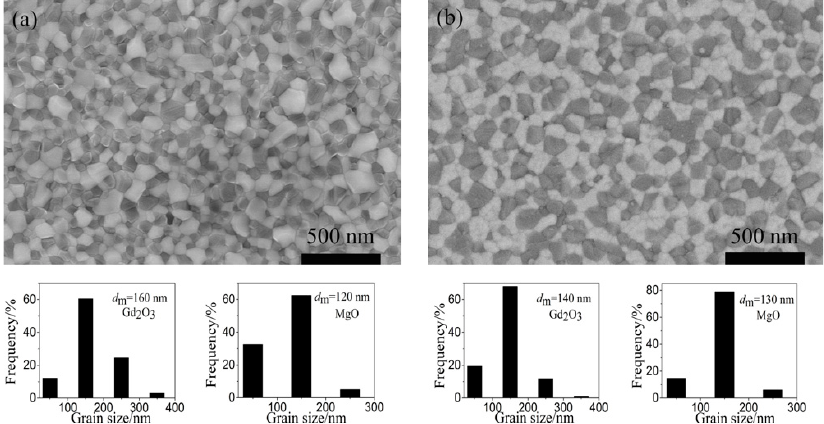
Figure 4. BSE images and grain size distributions of the sintered nanocomposite ceramics with nanocomposite powders with two methods: ( a ) urea precipitation; and ( b ) sol–gel.